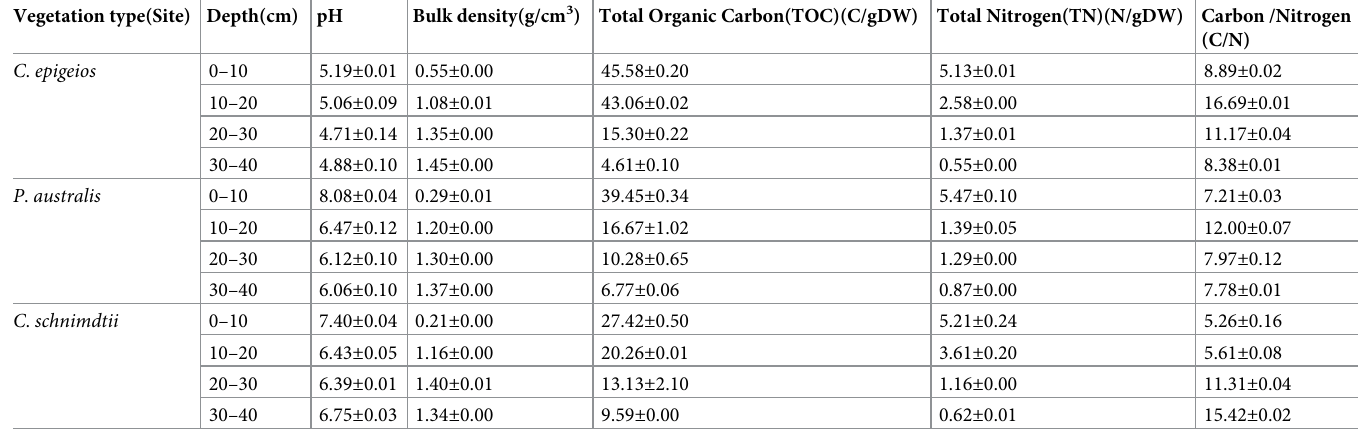
Table 1. Soil characteristics of the three studied wetland vegetation sites ( C . epigeios , P . australis and C . schnimdtii ) in Qixing River National Nature Reserve wet- land. Results are in mean ± SE. Vegetation type(Site) Depth(cm)